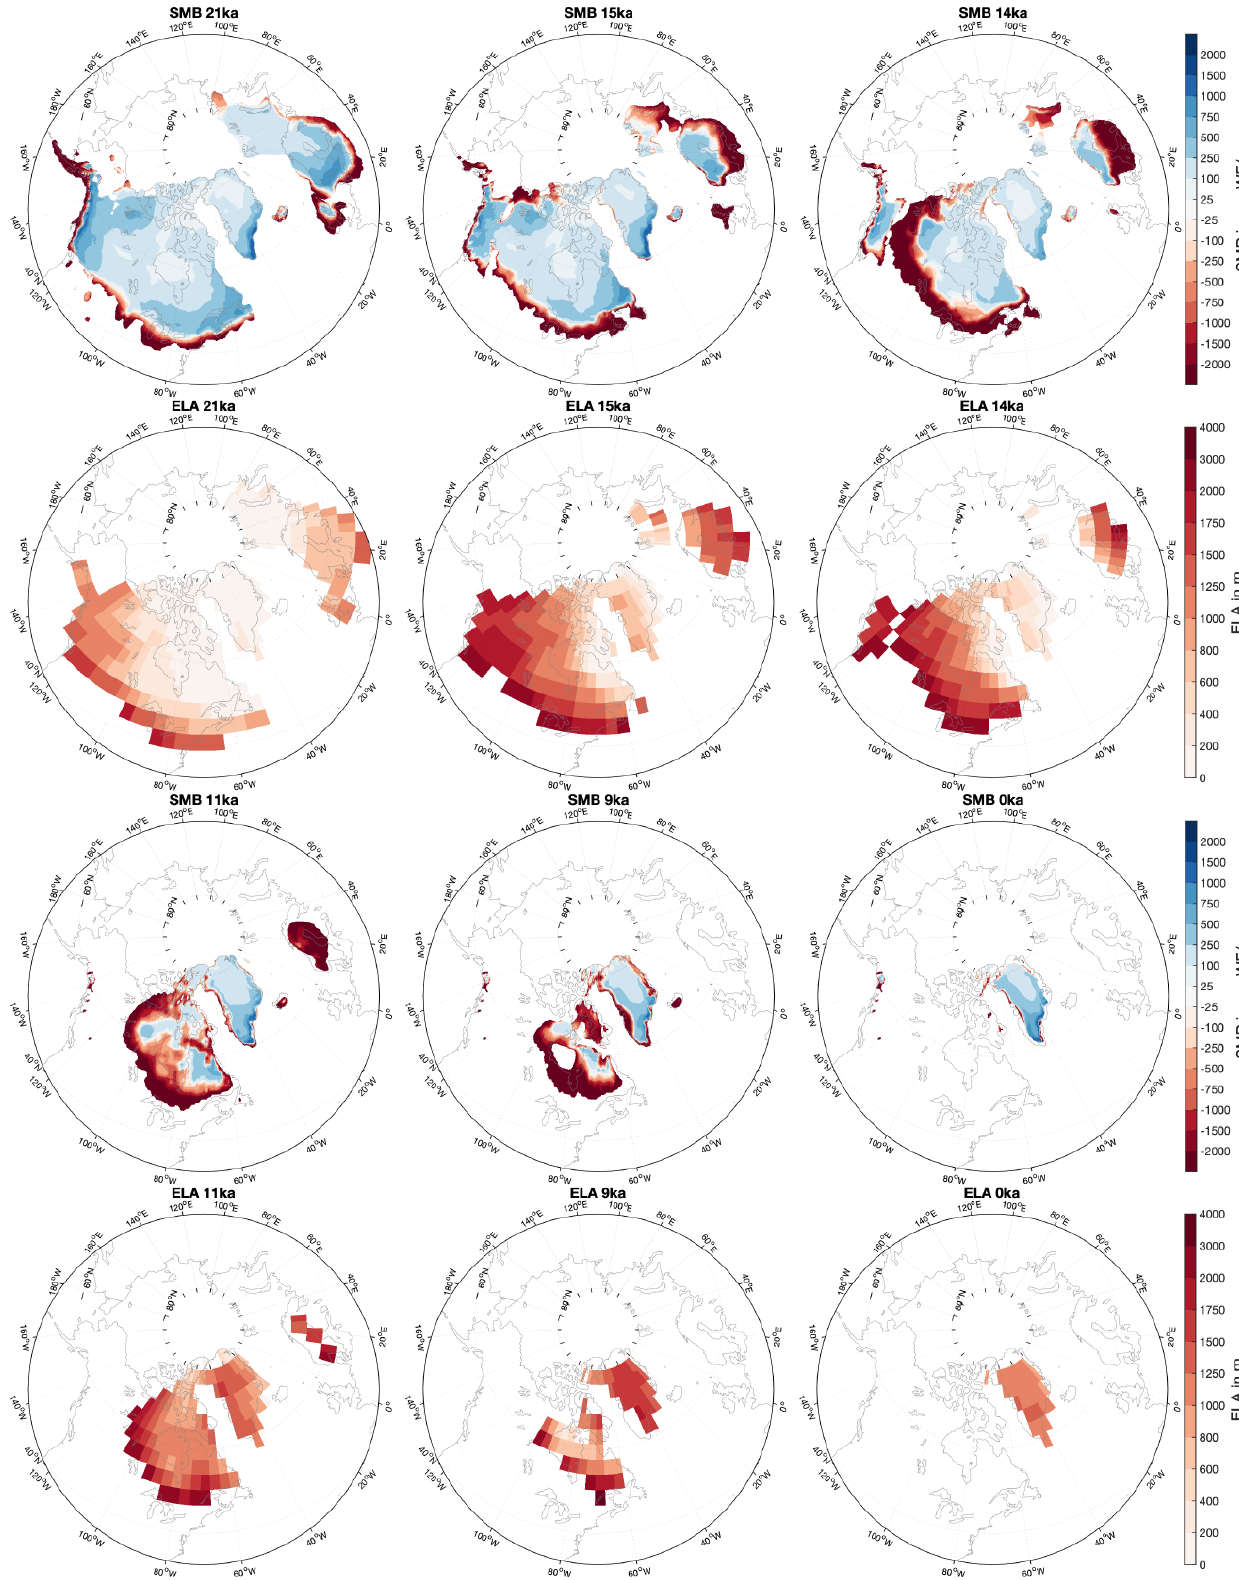
Figure A2. Similar to Fig. 4 but from the MPI-ESM-CR Ice6G simulation.